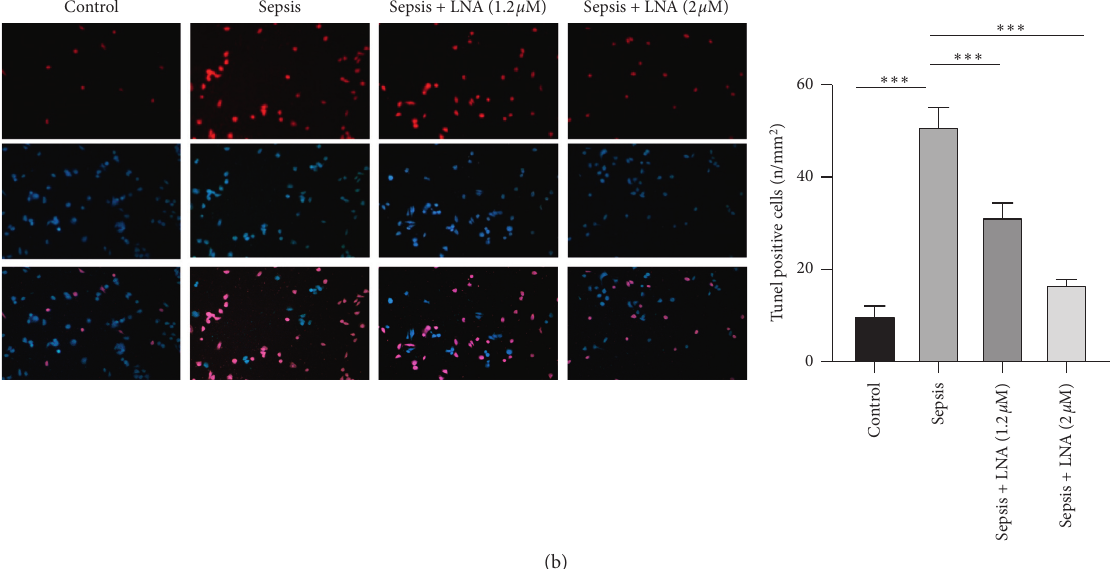
Figure 7: Lentinan inhibits apoptosis of endothelial cells in sepsis and expression of apoptosis-related proteins p65 and iNOS. In the control group, sepsis group, sepsis+LNA 1.2 μ M group, and sepsis+LNA 2 μ M group, (a) the flow cytometry Annexin V-FITC/PI double-labeling method was used to detect apoptosis and (b) TUNEL staining was used to detect apoptosis. Red dots denote that the nucleus stained positively by the TUNEL method, blue the nucleus of DAPI staining, while purple double staining. Values are expressed as mean ± standard deviation ( n � 3). Compared with the control group or sepsis model group, ∗∗ P < 0 . 01 and ∗∗∗ P < 0 .